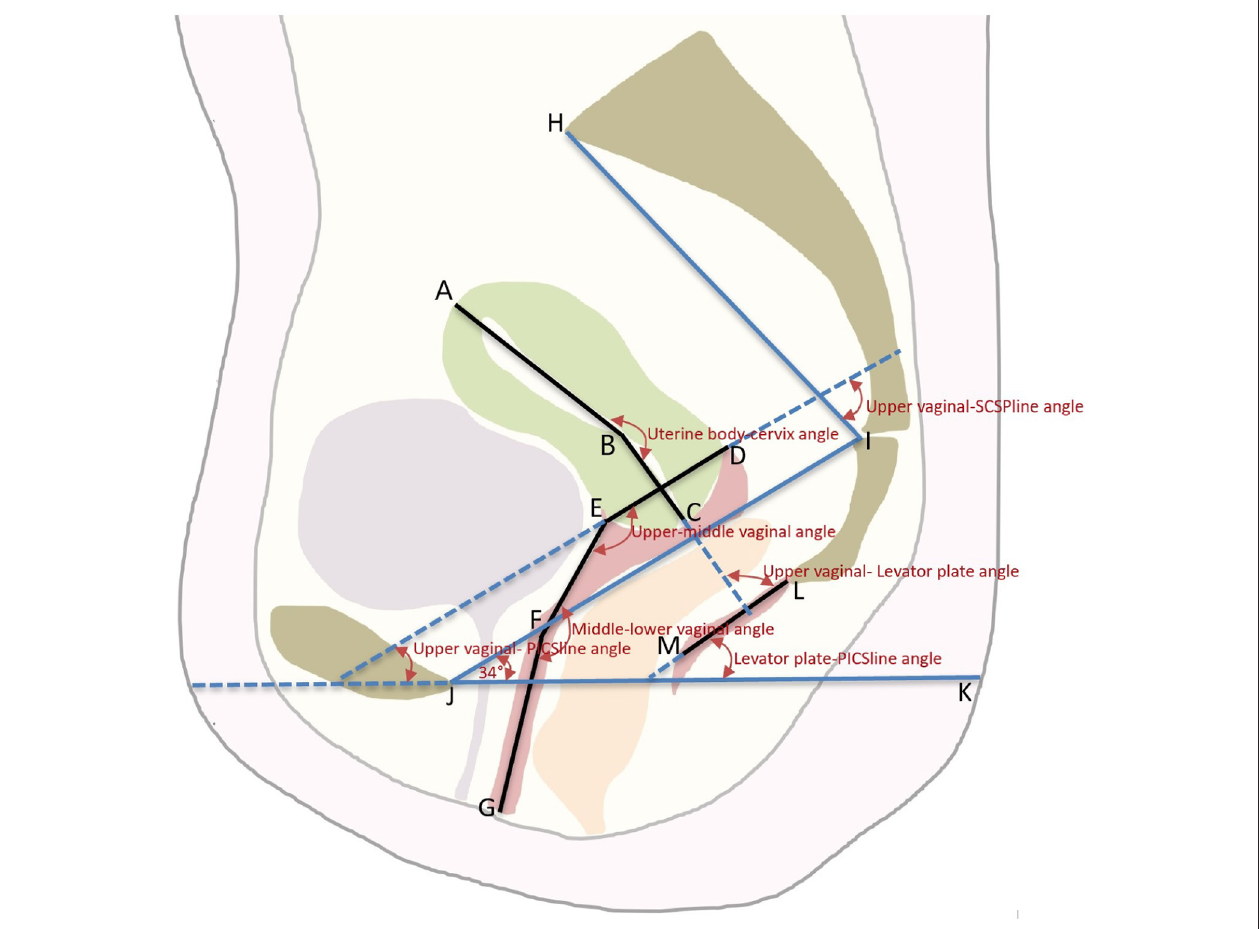
FIGURE 1 | The schematic diagram of the axis and position of the Uterus and Vagina. An illustration of the pelvic landmarks, uterine and vaginal regions, uterine and vaginal axes, and uterine and vaginal angles used in this study is shown. A, uterine floor; B, internal orifice of the cervix; C, external orifice of the cervix; D, posterior vaginal fornix; E, anterior vaginal fornix; F, junction of the middle and lower vagina; G, vaginal introitus; AB, uterine body axis; BC, cervical axis; DE, upper vaginal axis; EF, middle vaginal axis; FG, lower vaginal axis; LM, levator plate; JI, SCIPP sacrococcygeal-inferior pubic point line; JK, pelvic inclination correction system (PICS) line; HI, SCSP line, obtained by connecting a line drawn from the sacral promontory to the junction of the fifth sacral and first coccygeal bone.